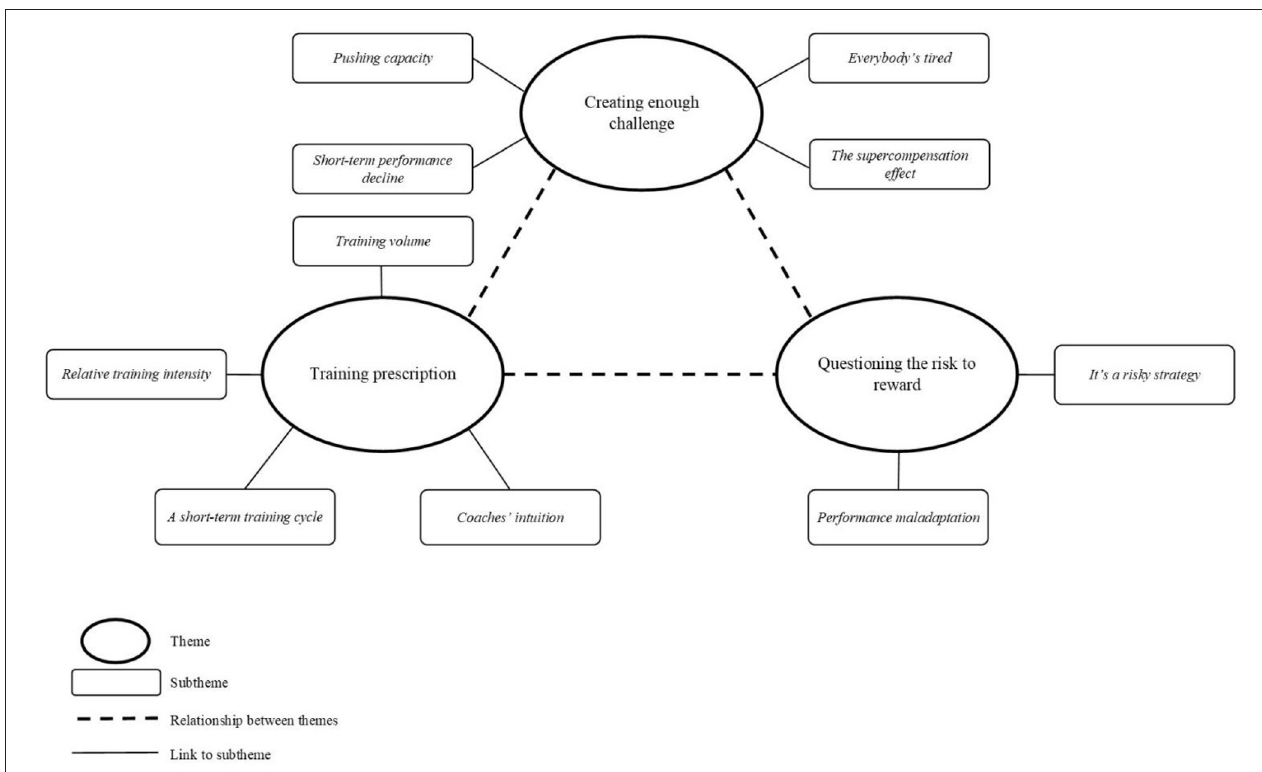
FIGURE 1 | Schematic diagram of themes and subthemes.